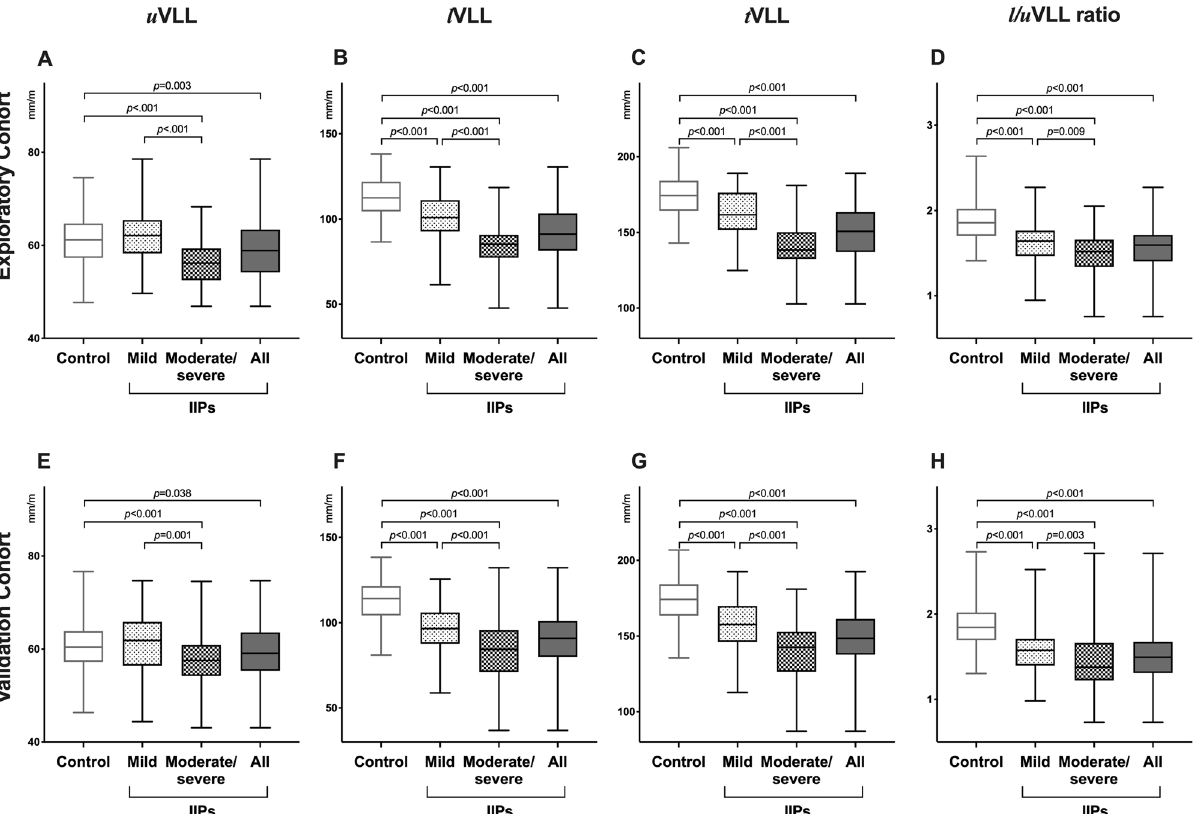
Figure 3. Comparison of vertical lung lengths (VLLs) between patients with IIPs and controls. VLLs in the exploratory ( A – D ) and validation cohorts ( E – H ). Mild and moderate/severe idiopathic interstitial pneumonias (IIPs) were defined as patients with %predicted forced vital capacity ≥ 80% and < 80%, respectively. White, black, light grey, and grey boxes represent controls, all patients with IIPs, mild IIPs, and moderate/severe IIPs,